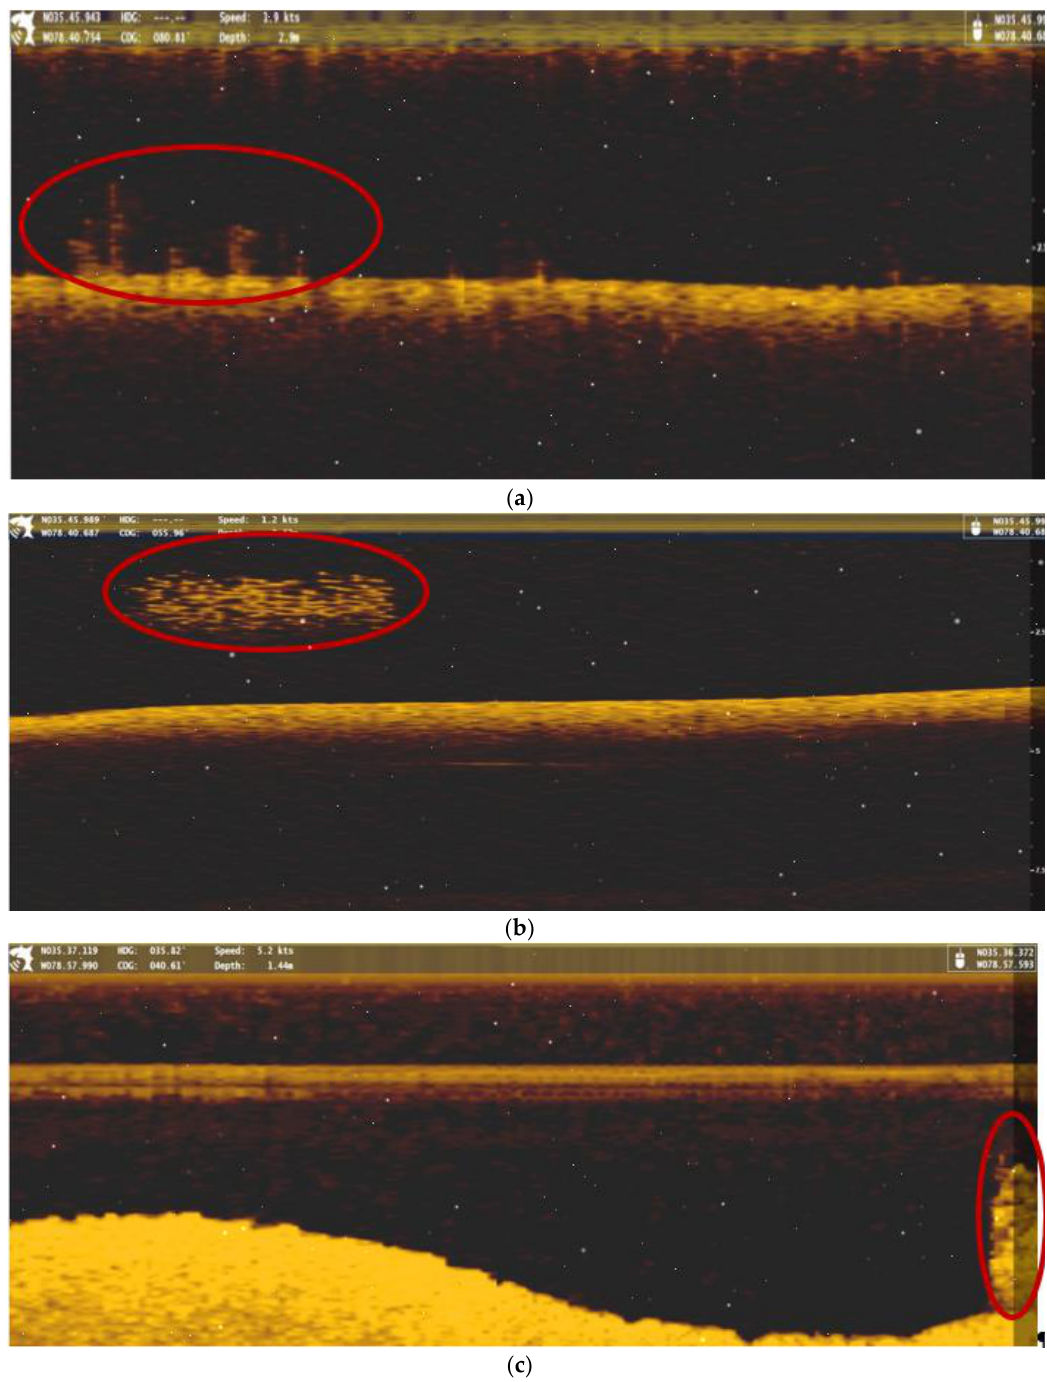
Figure 21. Misclassified images due to ( a ) limited vegetation growth, ( b ) floating vegetation or schools of fish, and ( c ) vegetation partially contained within the image.